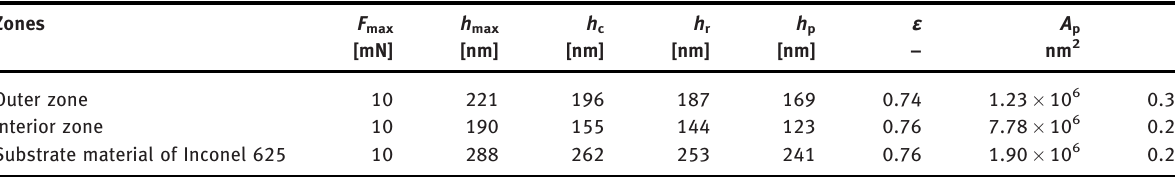
Table 2: Average values of the parameters defined in the nanohardness measurements of the coating zones and substrate material (8 h CVD